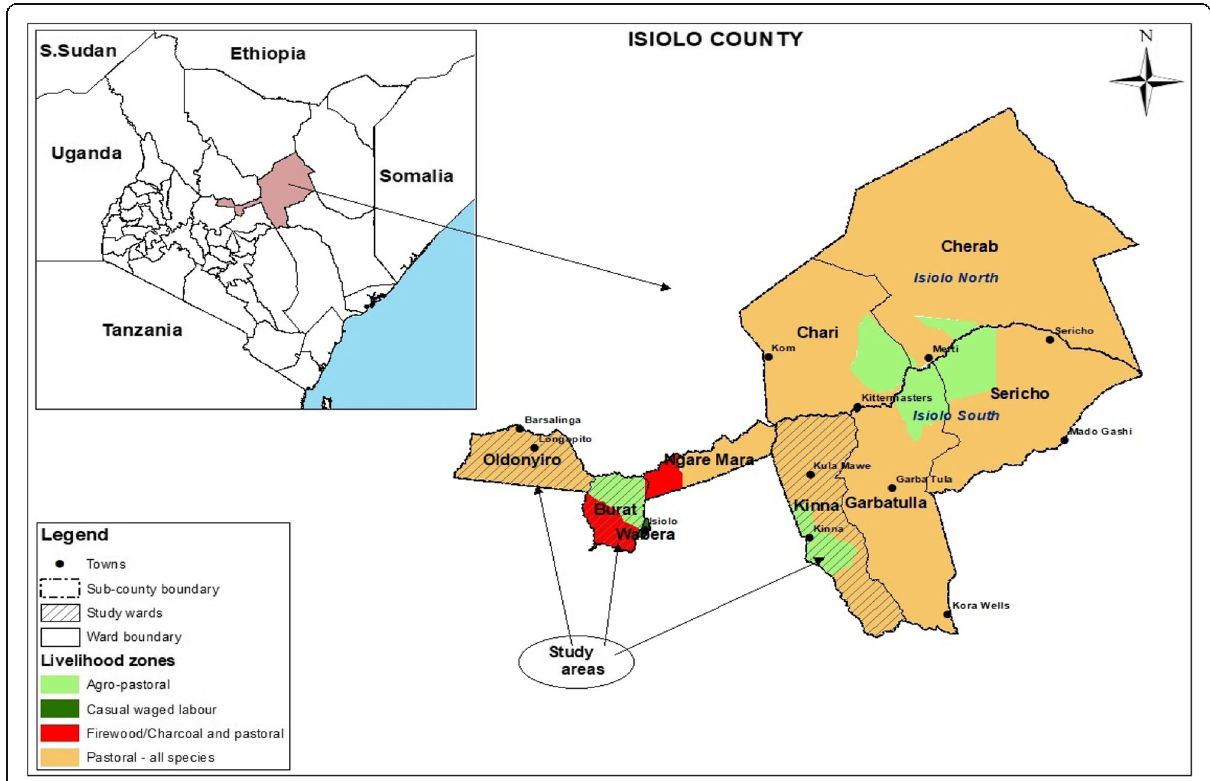
Fig. 1 Livelihood zones of Isiolo County and study sites. Source: Fews.netBoundaries:gadm.org (2019)